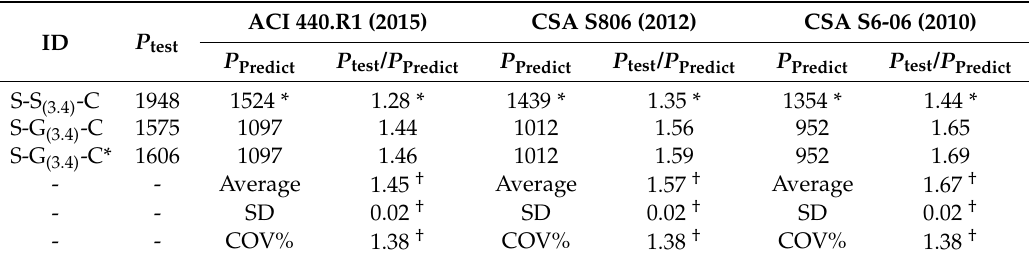
Table 5. Code predications comparisons versus test results for control (RC)